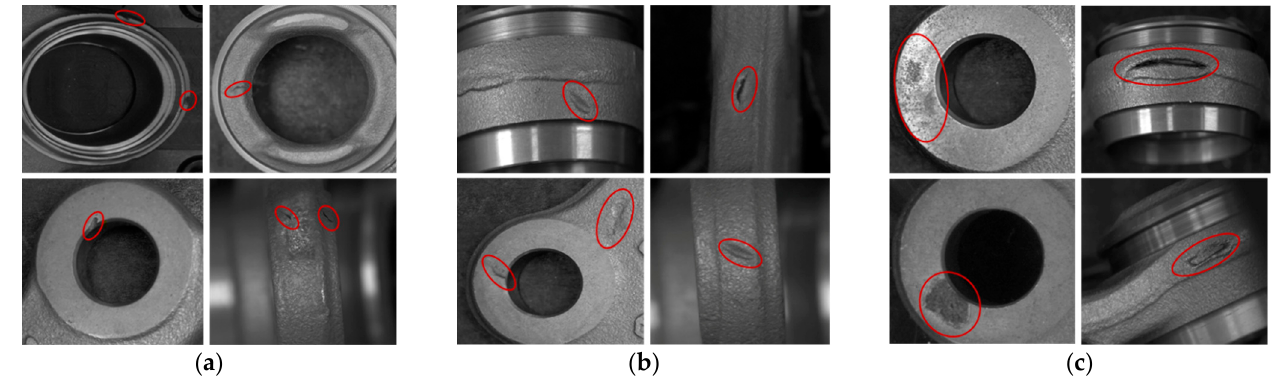
Figure 3. Demonstration of 3D ball joint socket product defects and defect sizes. ( a ) Small defects—1.5–3 mm, ( b ) medium defects—3–6 mm, ( c ) big defects—6–10 mm.